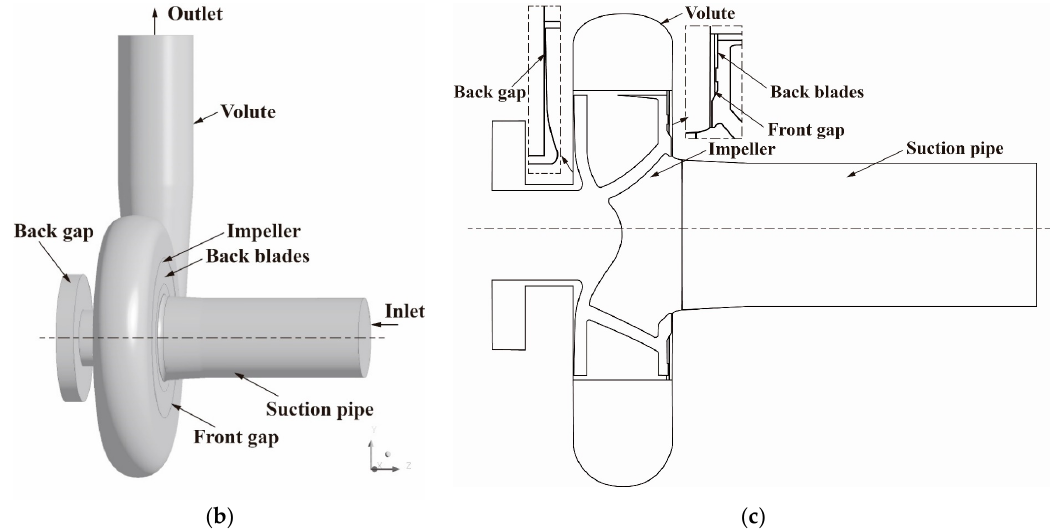
Figure 1. Assembly drawing and computing domains of the centrifugal pump. ( a ) Cross-sectional assembly drawing of the centrifugal pump; ( b ) computing domains; and ( c ) meridional view of the computing domains.